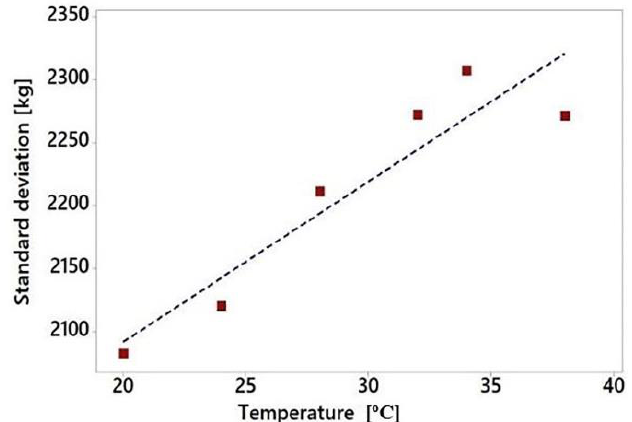
Figure 18. Inferred steer-axle weight standard deviation against the bridge internal temperature.